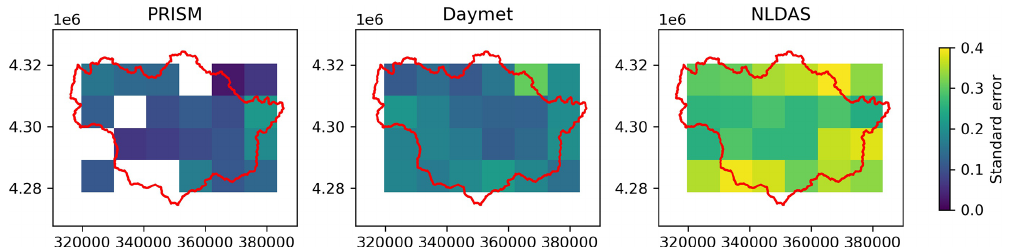
Figure A1. TCA results for precipitation data in the three GMFs. The color map shows the standard error (the lower the better) for each pixel region.